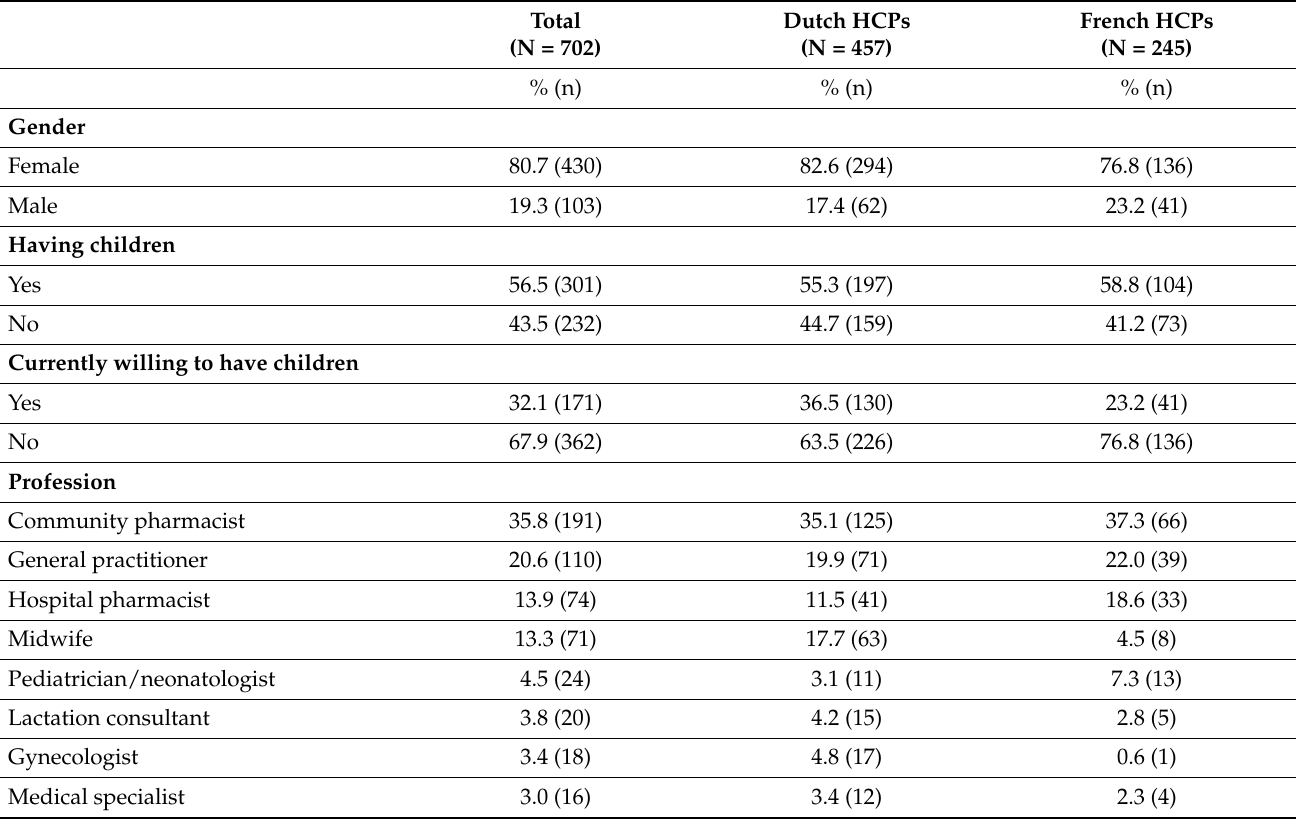
Table 2. Characteristics of the participating HCPs according to language of survey completion (N = 702).